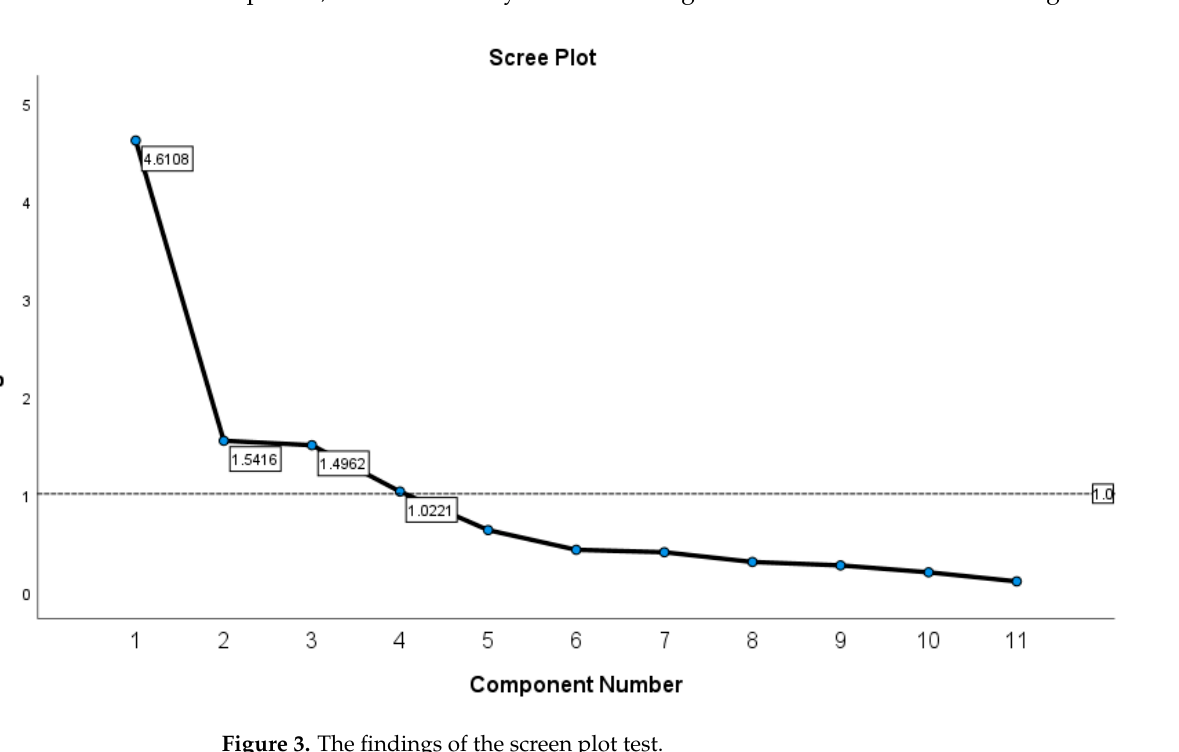
Figure 3. The findings of the screen plot